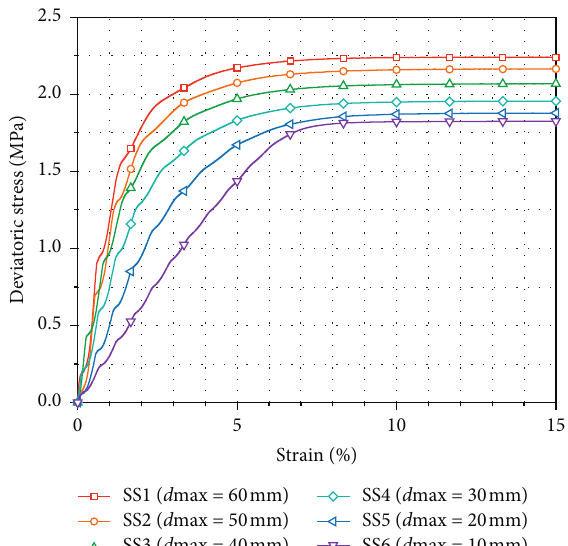
Figure 11: Stress-strain curves of each scheme at 1600kPa confining pressure.